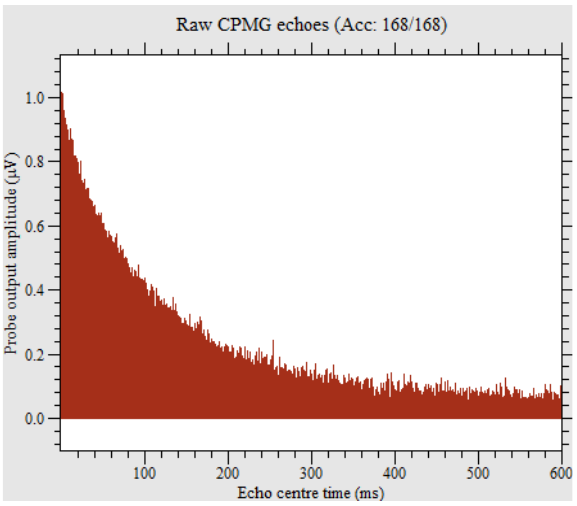
Figure 6. CPMG echo of a sample.